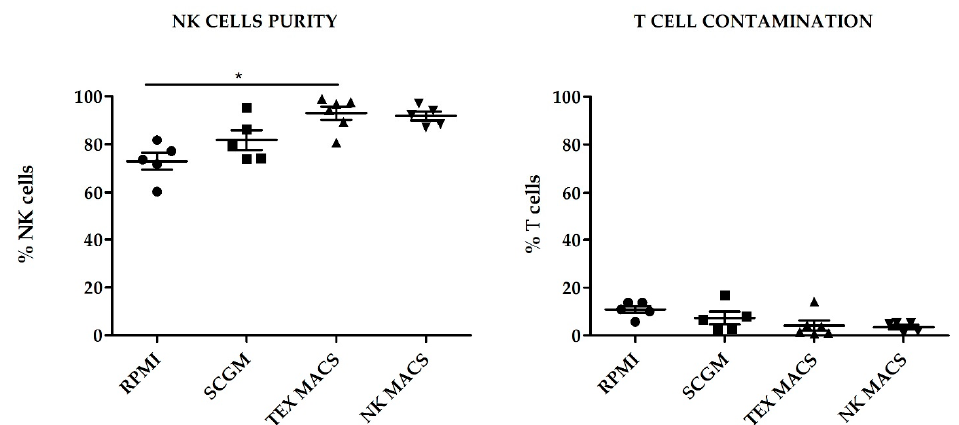
Figure 2. NK cell purity and T cell contamination on activated and expanded NK cells (NKAE) expanded with different culture media. Error bars show mean ± SEM. RPMI, SCGM and NK MACS n = 5. TexMACS n = 6. * p < 0.05. Geometrical symbols represent individual data of expanded cells from different donors by using RPMI (dots), SCGM (squares), TexMACS (triangles), NKMACS (inverted triangles).